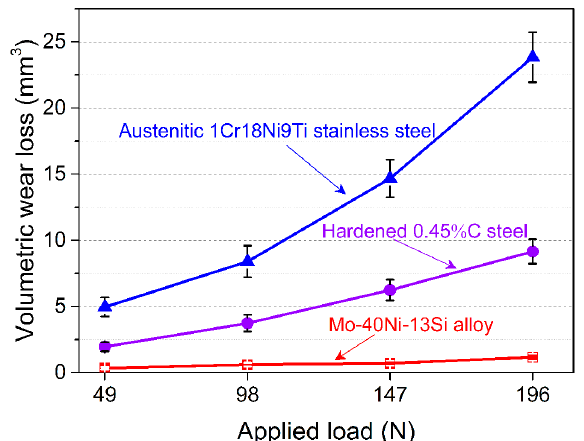
Figure 4. Volumetric wear loss of the Mo–40Ni–13Si alloys and reference test materials as a function of applied load under room temperature dry-sliding wear conditions.